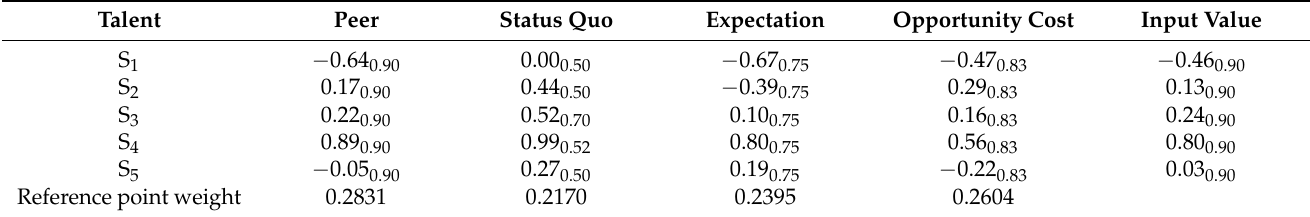
Table 5. Input value and reference point weight under different reference points.